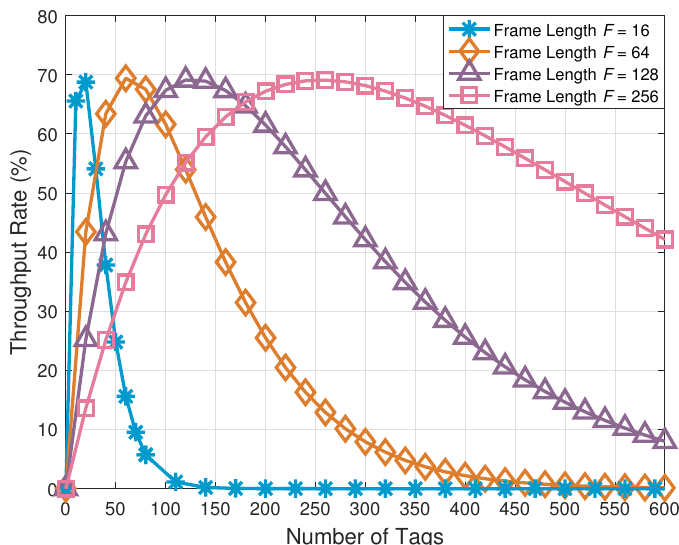
Figure 6. Comparison of the throughput rate with respect to the number of tags under the different frame